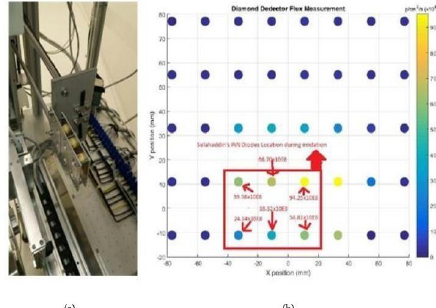
Fig. 10 . In (a), the pin diodes under test are seen in the movable holder of the test desk. In (b), measurement positions and fluxes for each measurement taken by the diamond detector (right) is shown with a color scale. The maximum flux (1.88 x 10 11 p/cm 2 /s) and minimum flux (4.82 x 10 10 p/cm 2 /s) seen in the test area shown in red.